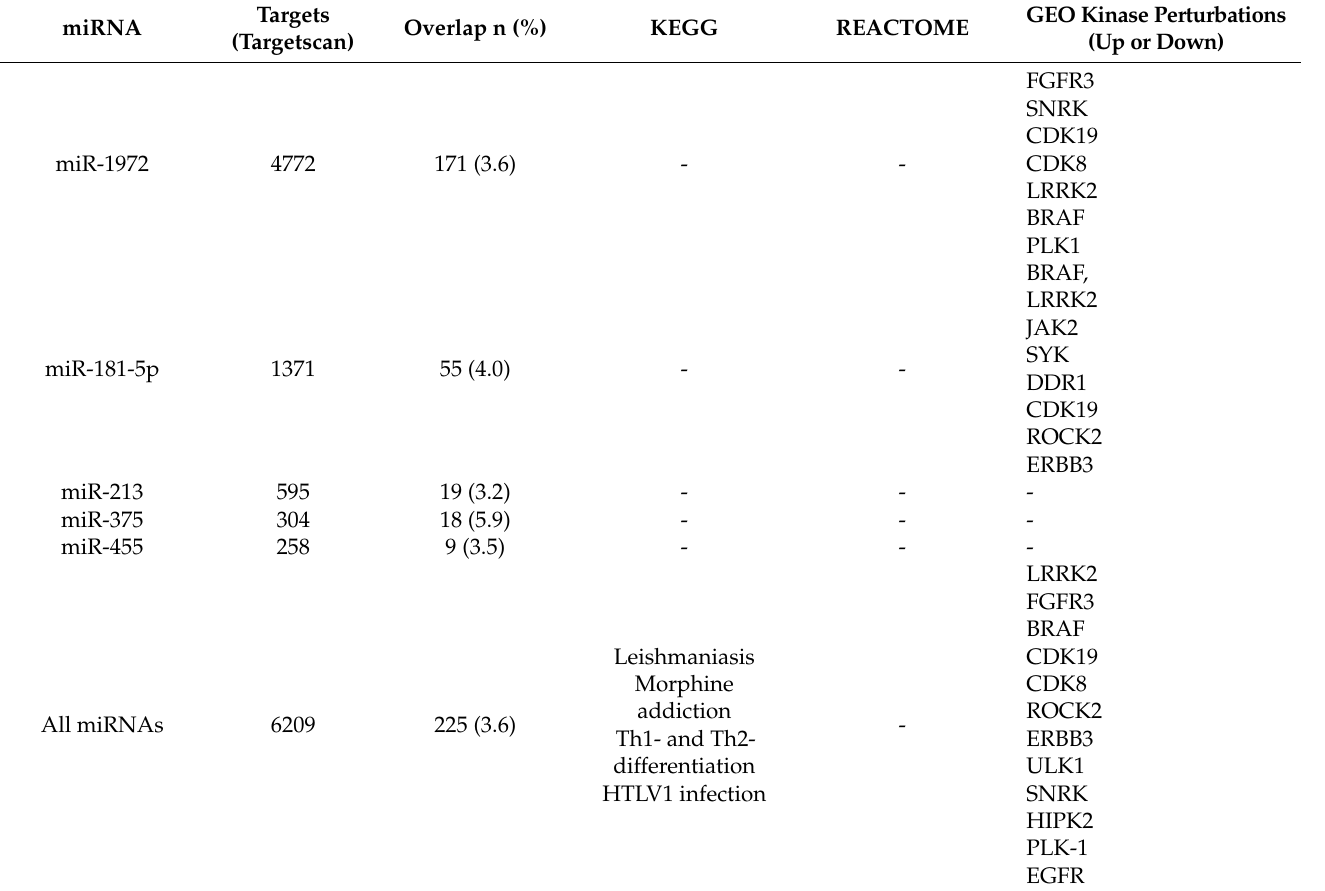
Table 4. Enrichment analysis for significant miRNA-mRNA consensus lists made by the